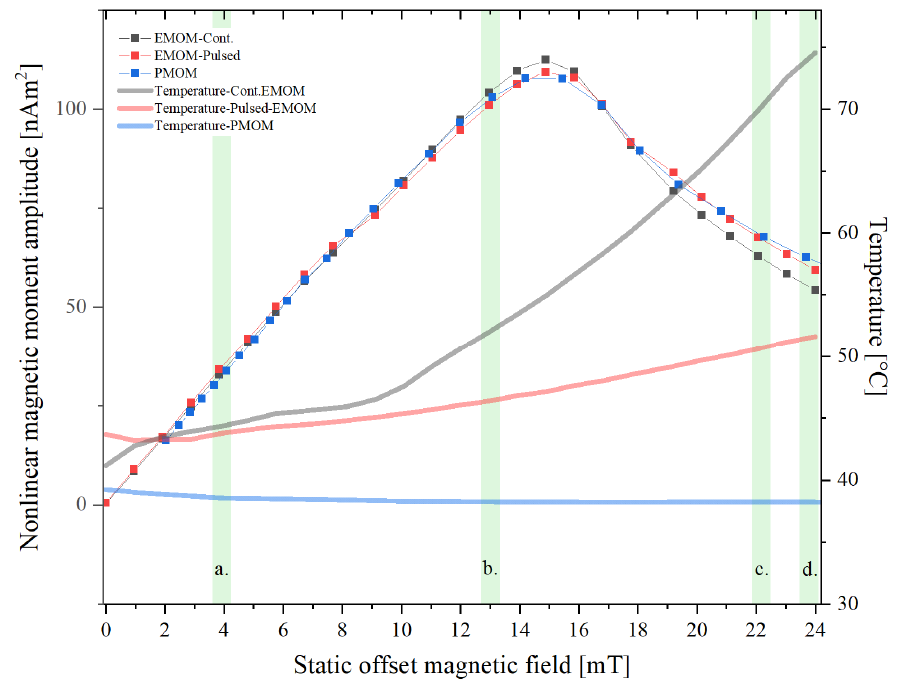
Figure 5. Nonlinear magnetic moment trace of sample Syn70 measured with the PMOM setup (blue squares), and with the EMOM setup in pulsed (red squares) and continuous (black squares) mode over a field range of 0 to 24 mT, for mixing harmonic f 1 + f 2 . The temperature development in the measurement head is plotted for each case as faded solid lines with matching colors. The signal values of the different setups for four different regions (a-d, marked in green) are given in Table 1.